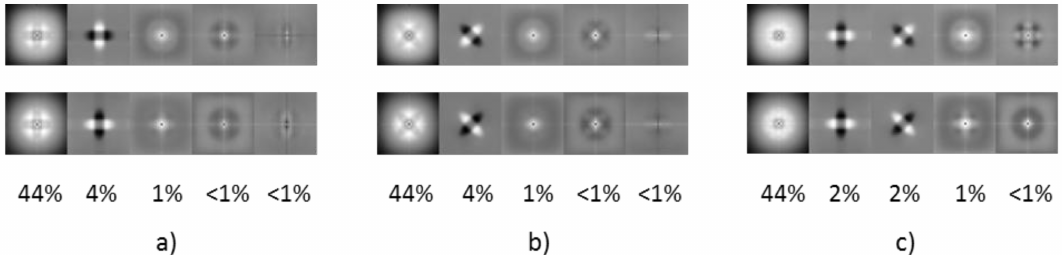
Figure 4. The first five PCA components of watermarked blocks with different orientations in the Cx (top) and Cz channel (bottom), rounded percentage of explained variance in the training set is shown below the components. ( a ) Two embeddable orientations, 0 ◦ and 90 ◦ ; ( b ) Two embeddable orientations, 45 ◦ and 135 ◦ ; ( c ) Four embeddable orientations, 0 ◦ , 45 ◦ , 90 ◦ and 135 ◦